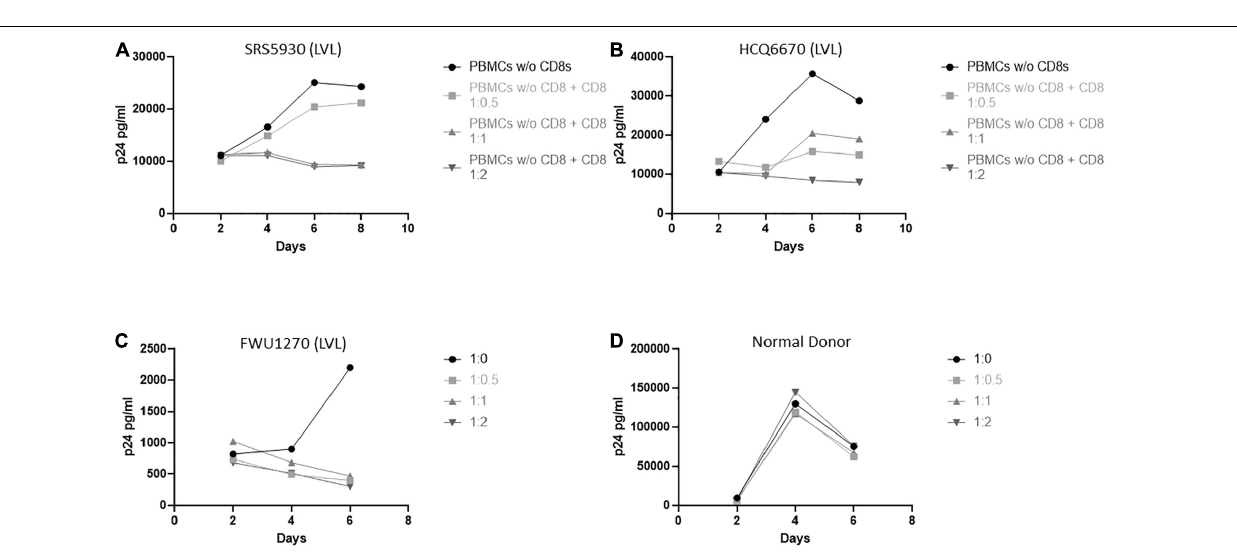
(blue lines) were evaluated for their ability to support